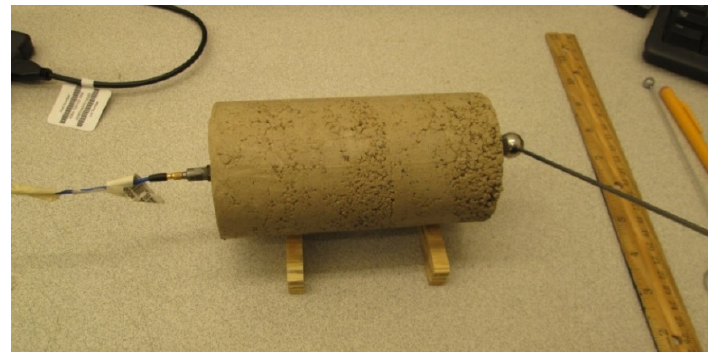
Figure 1. Cylindrical specimen and configuration for testing the longitudinal resonance frequency.